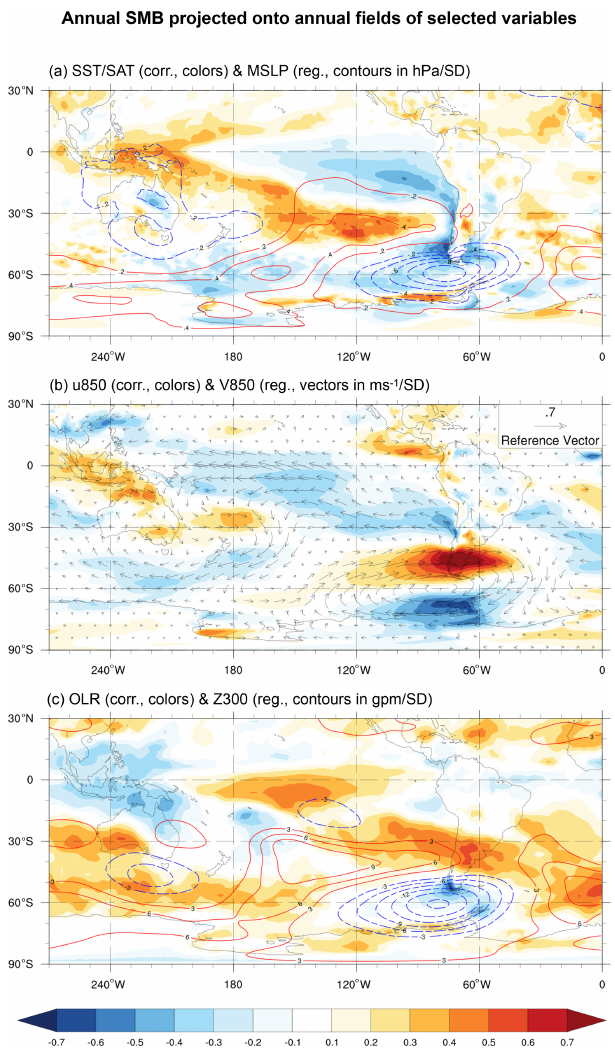
Figure 9. The same as in Fig. 8 but for the winter (April to Septem-